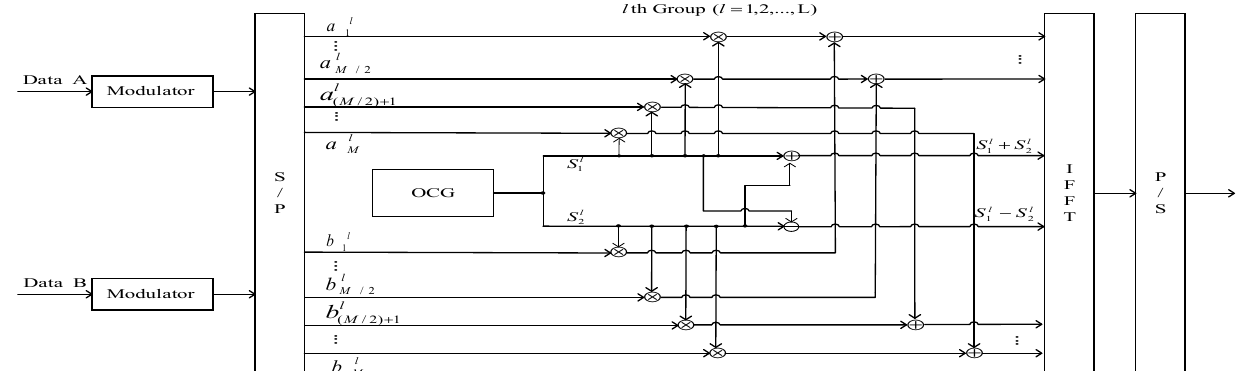
Figure 3. Transmitter of MC-ODBR-DCSK.